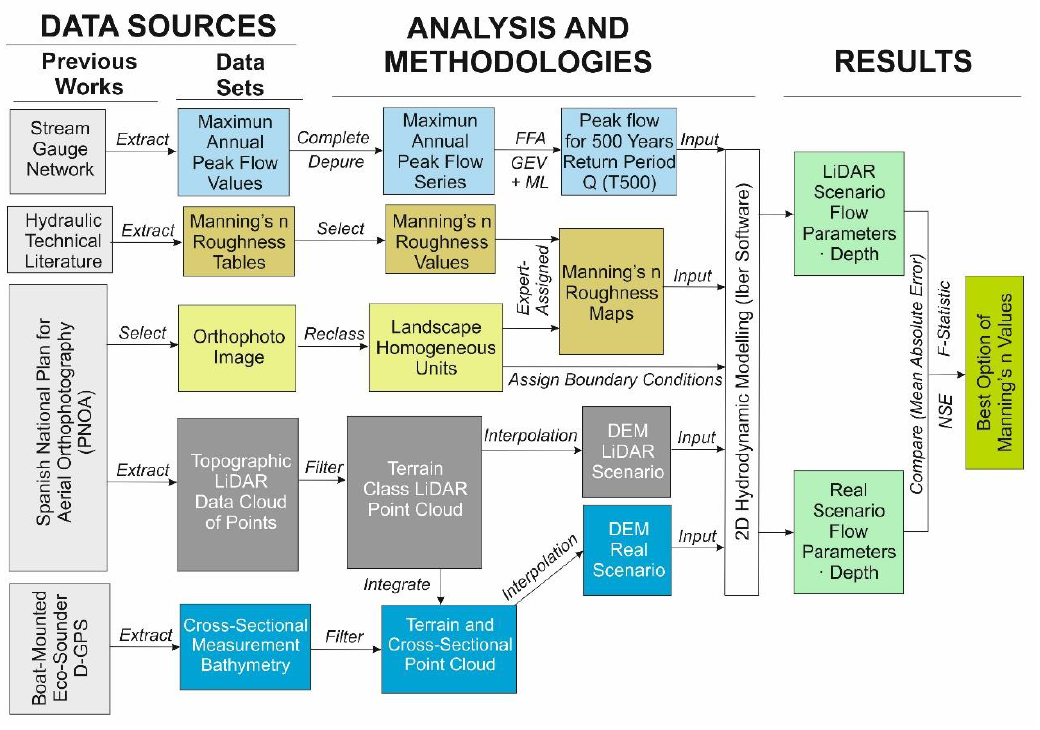
Figure 2. Flow chart of the full methodological approach that was used in the Manning ’ s n value calibration process, from data sources until the calibrated vs. control scenarios comparison.